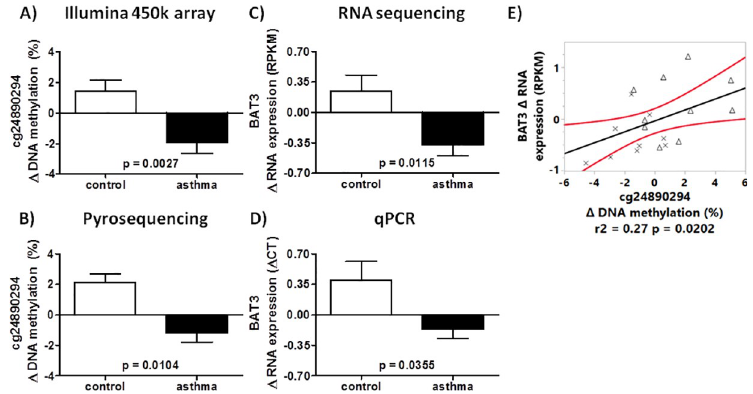
Fig 5. RIDM of cg24890294 in BAT3 in nasal epithelial cells of asthmatic and controls. Changes in DNA methylation were detected with a HumanMethylation450 BeadChip Kit (A), verified by pyrosequencing (B), and modified mRNA expression ( Δ HRVI-MOCK) detected by RNA sequencing (C) and qPCR (D). The correlation between change in DNA methylation of cg24890294 and change in mRNA expression of BAT3 (E). Crosses represent children with asthma and the triangles represent controls.